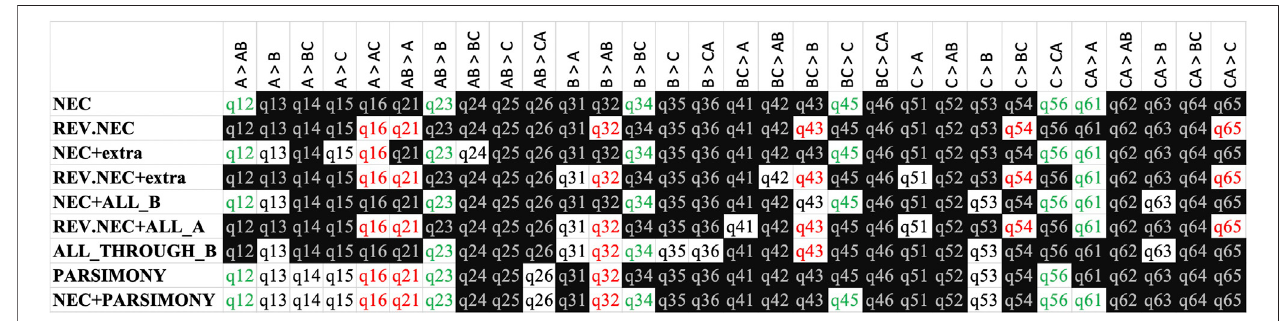
FIGURE 10 | Overview of the manual models. Shaded transition rate parameters are excluded; non-shaded transition rate parameters are included (but not necessarily turned on). Green indicates the six transition rate parameters that model the NEC; red indicates the transition rate parameters that reverse the NEC.